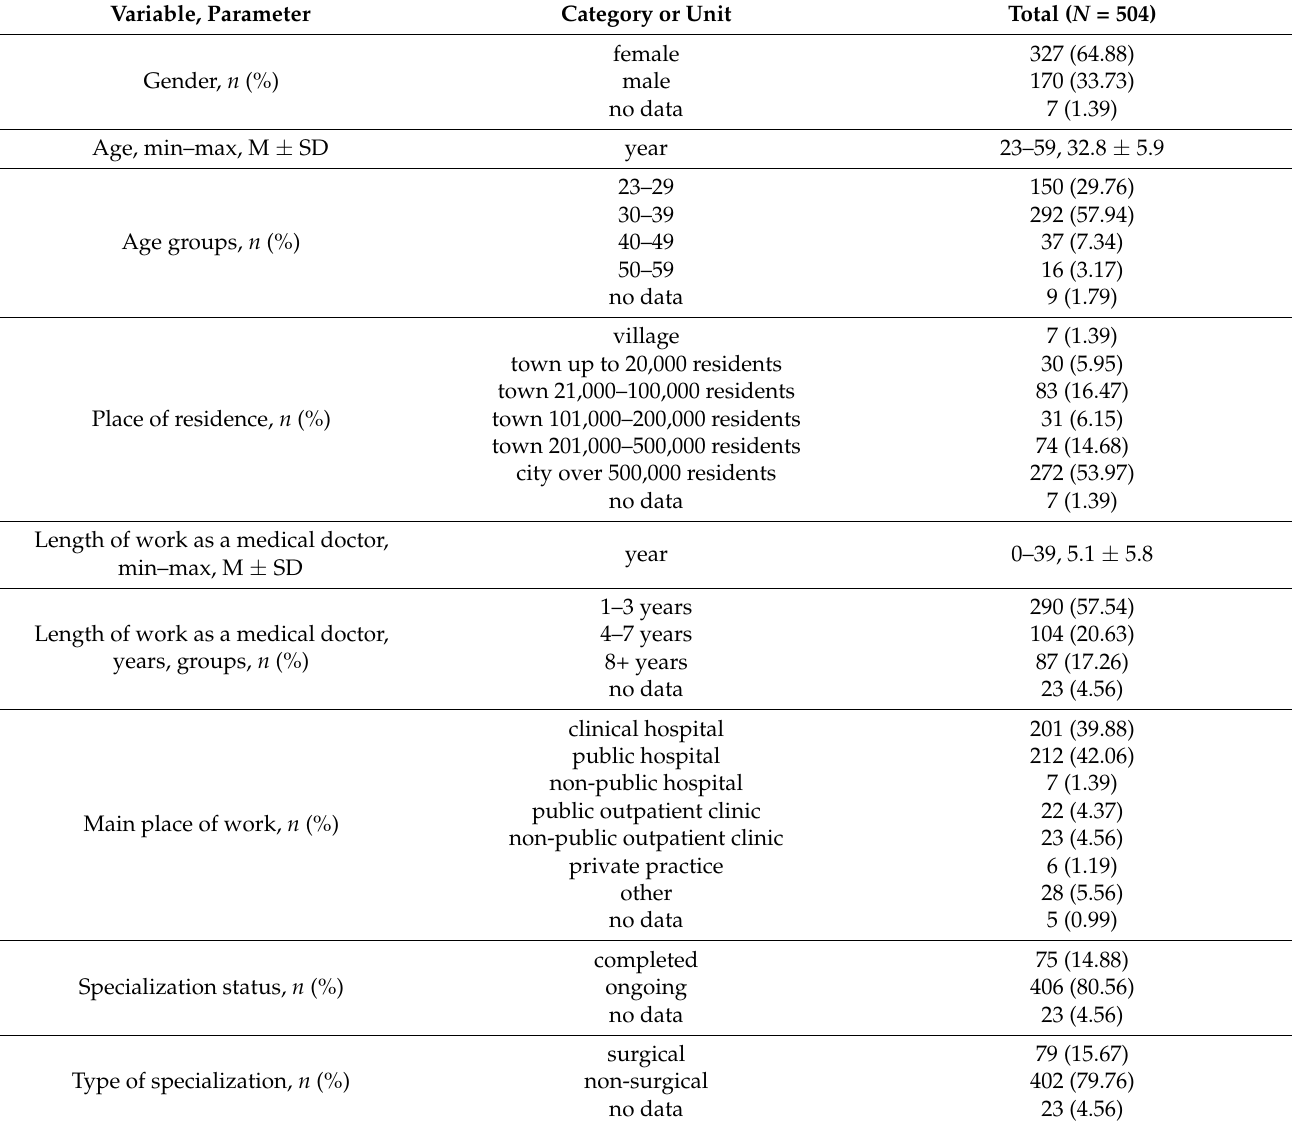
Table 1. Characteristics of the study